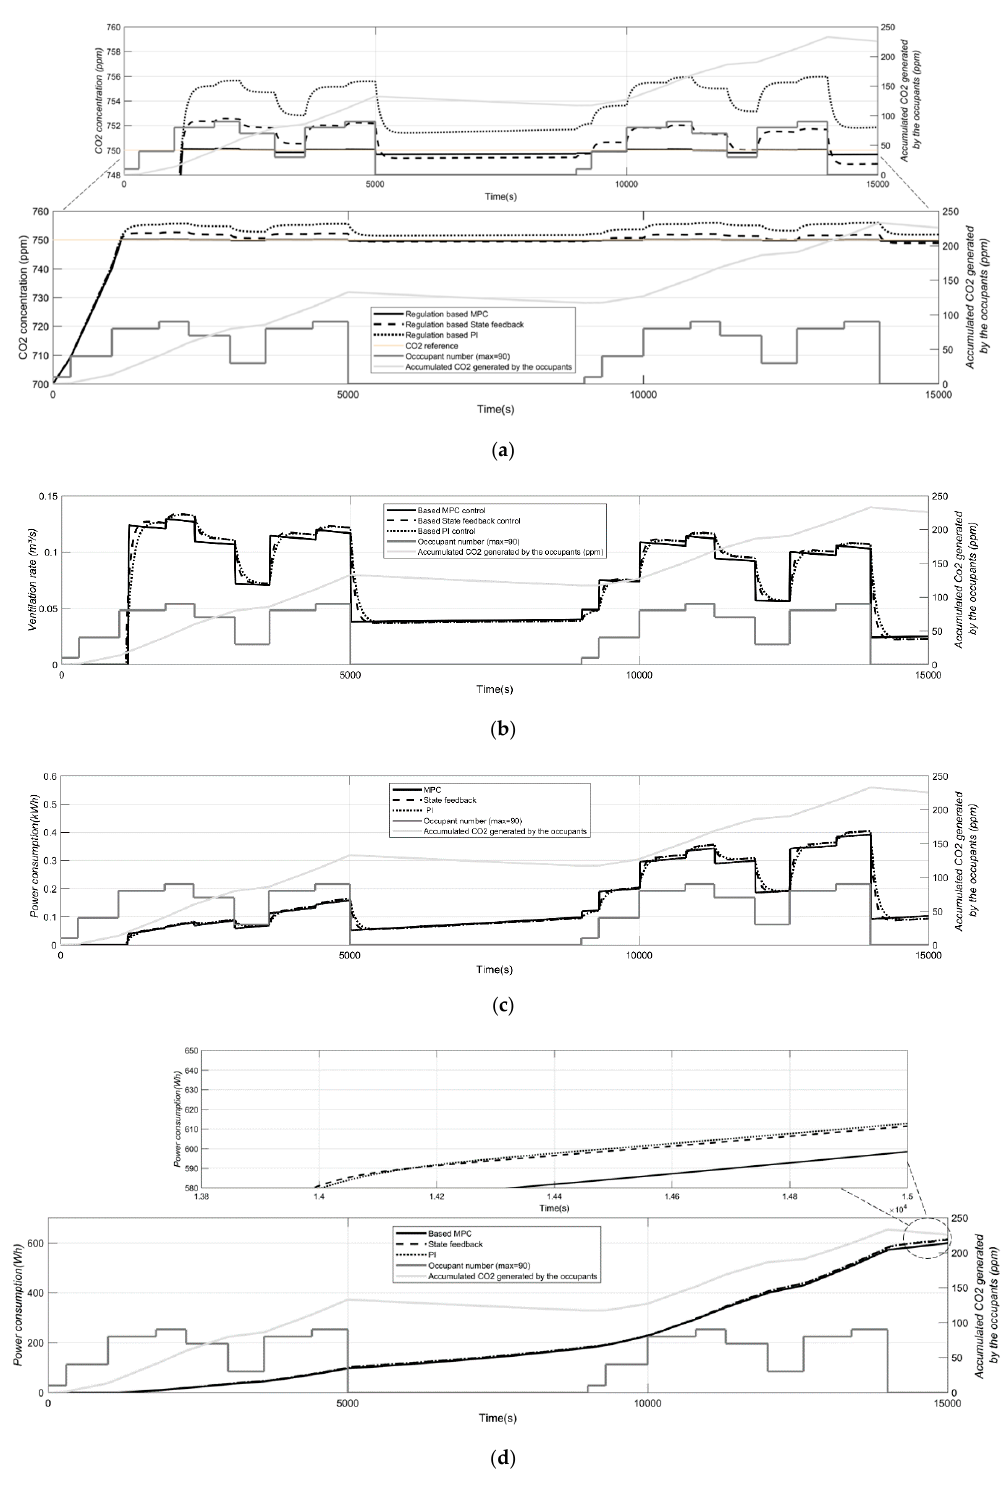
Figure 3. MPC vs. PI and state feedback (SF): ( a ) the CO2 regulation, ( b ) the ventilation air flow rate, ( c ) the instantaneous power consumption, and ( d ) the accumulated power consumption.